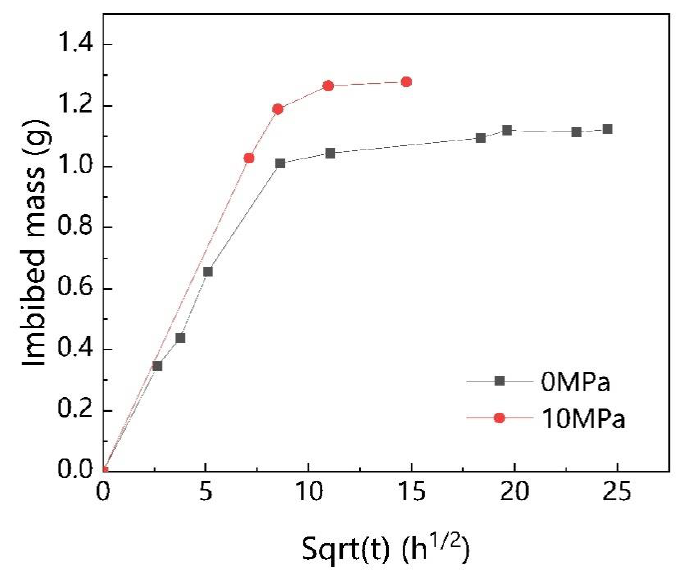
Figure 11. Development of imbibition mass of sample XBL under 1 atm and 10 MPa.